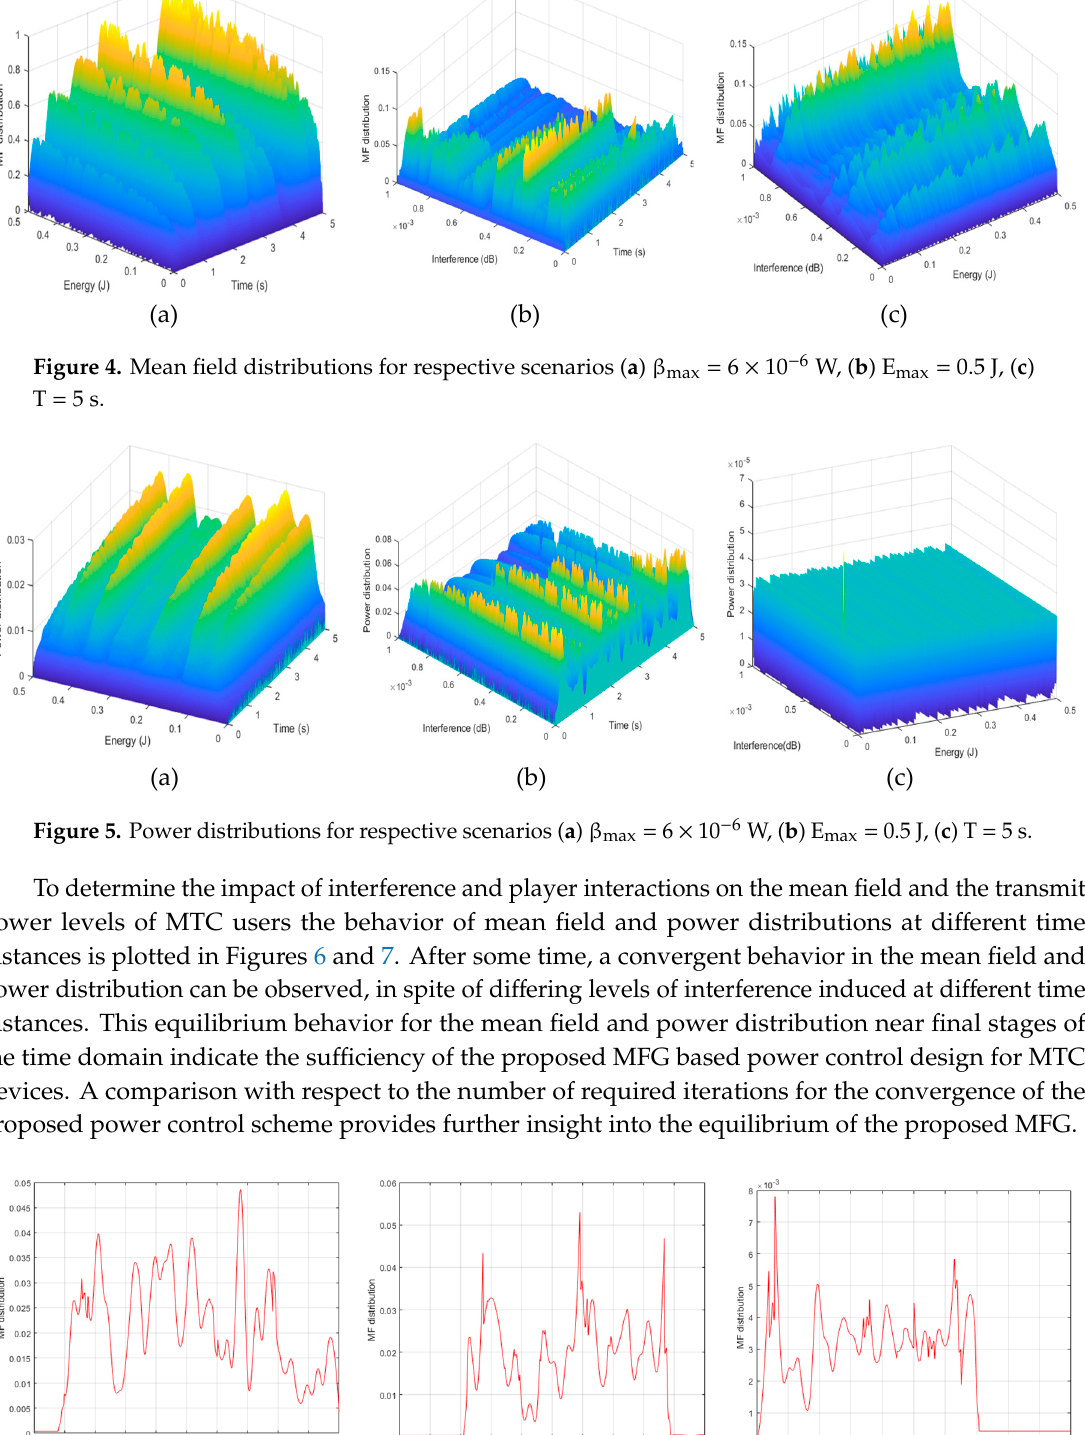
Figure 6. Mean field distributions at varying time instances with equilibrium evolution, (a) T = 2 s, (b) T = 3.5 s, (c) T = 5 s.